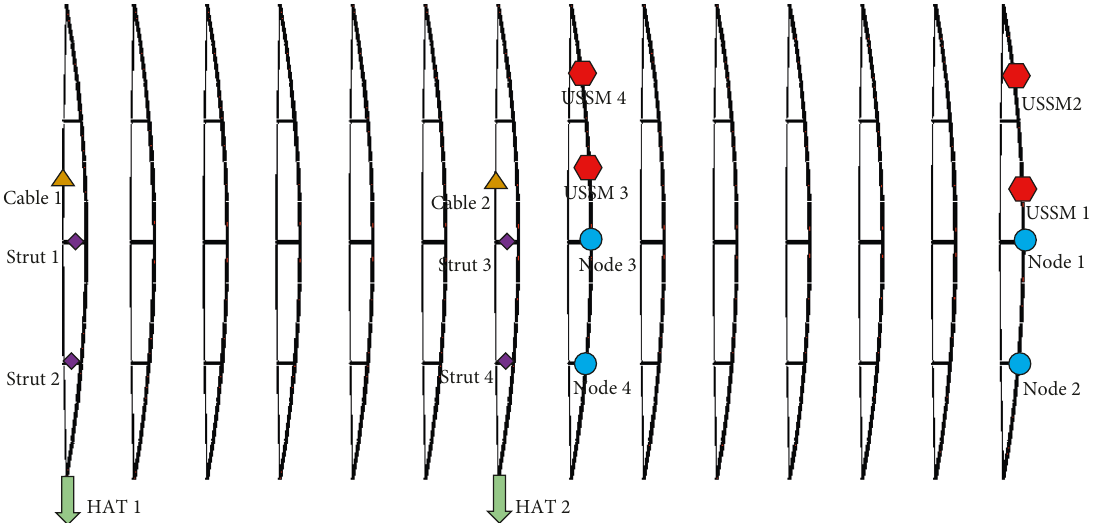
Figure 2: Targets of the numerical simulation analysis with a full-span load distribution.